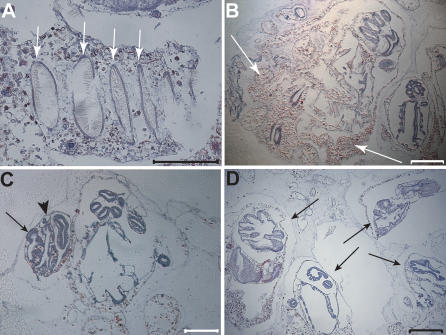
All-trans RA Leads to Accelerated Regeneration and Multibud FormationRA-treated regenerating fragments that were sectioned at different final stages of the regeneration process show a remarkable accelerated regeneration. By days 6–7 postseparation, most of the regenerating buds reached these final stages (compared to 10–14 days in control experiments), exhibiting complete organogenesis. The regenerating zooids manifested fully differentiated organ systems such as stigmata with cilia (A, arrows). Different from normal blastogenic buds or control experiments, blood cells extensively colonized these regenerating buds between atrial folds and throughout internal cavities (B, arrows). The acceleration of the process was also exemplified in the subsequent blastogenesis. At day 7, the regenerating bud progressed to the stage where secondary buds were formed on the primary palleal buds (C, arrow and arrowhead, respectively). In marked contrast to control regenerating fragments, where only a single bud was developed, numerous buds at different regeneration niches simultaneously reached the final stages of organogenesis (2–5 functional zooids) (D, arrows, compare to Figure 2G). Scale bar represents 100 μm.